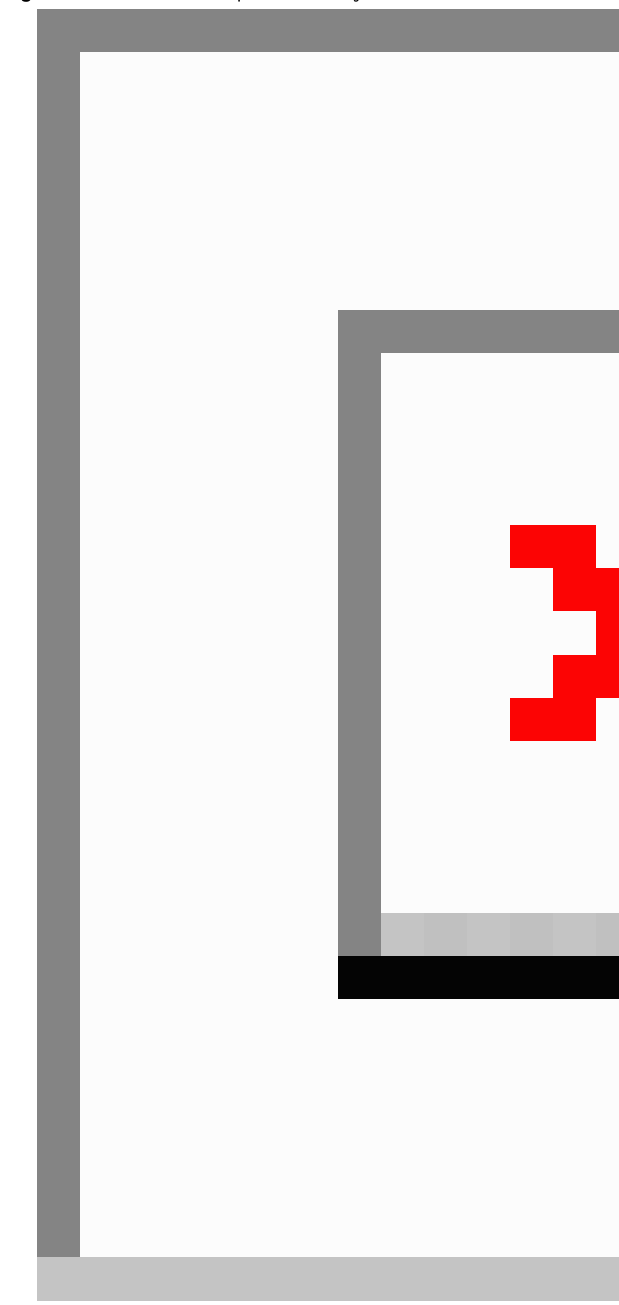
Figure 1. Evolution of the pulse oximetry